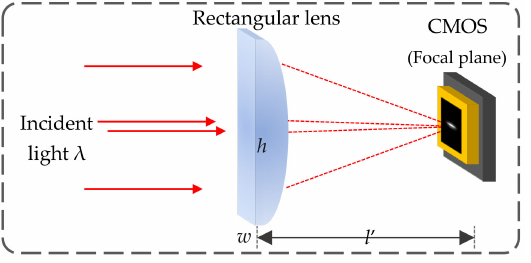
Figure 2. Simplified imaging mechanism of RRA